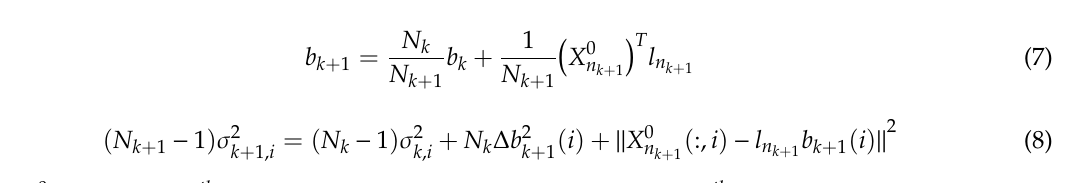
Table 1. Parameters of recursive principal components analysis (RPCA) Model. Symbol Parameter Symbol Parameter b k vector of mean R k covariance matrix (cid:80) Λ k eigenvalue matrix k standard deviation matrix X k standard data matrix P k load